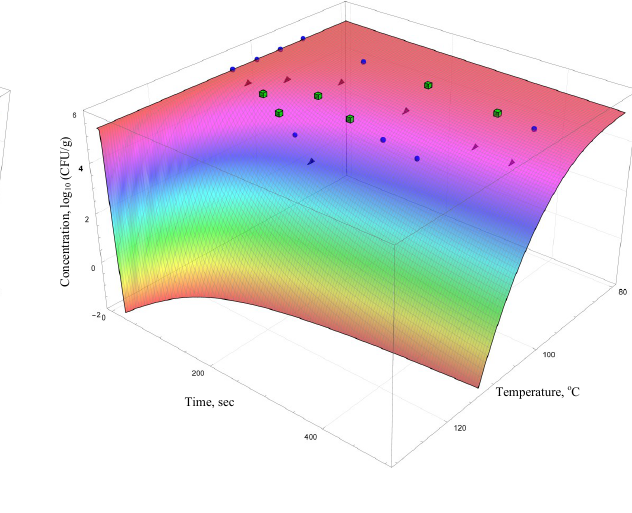
(a) Membre model, (b) Augustin model.